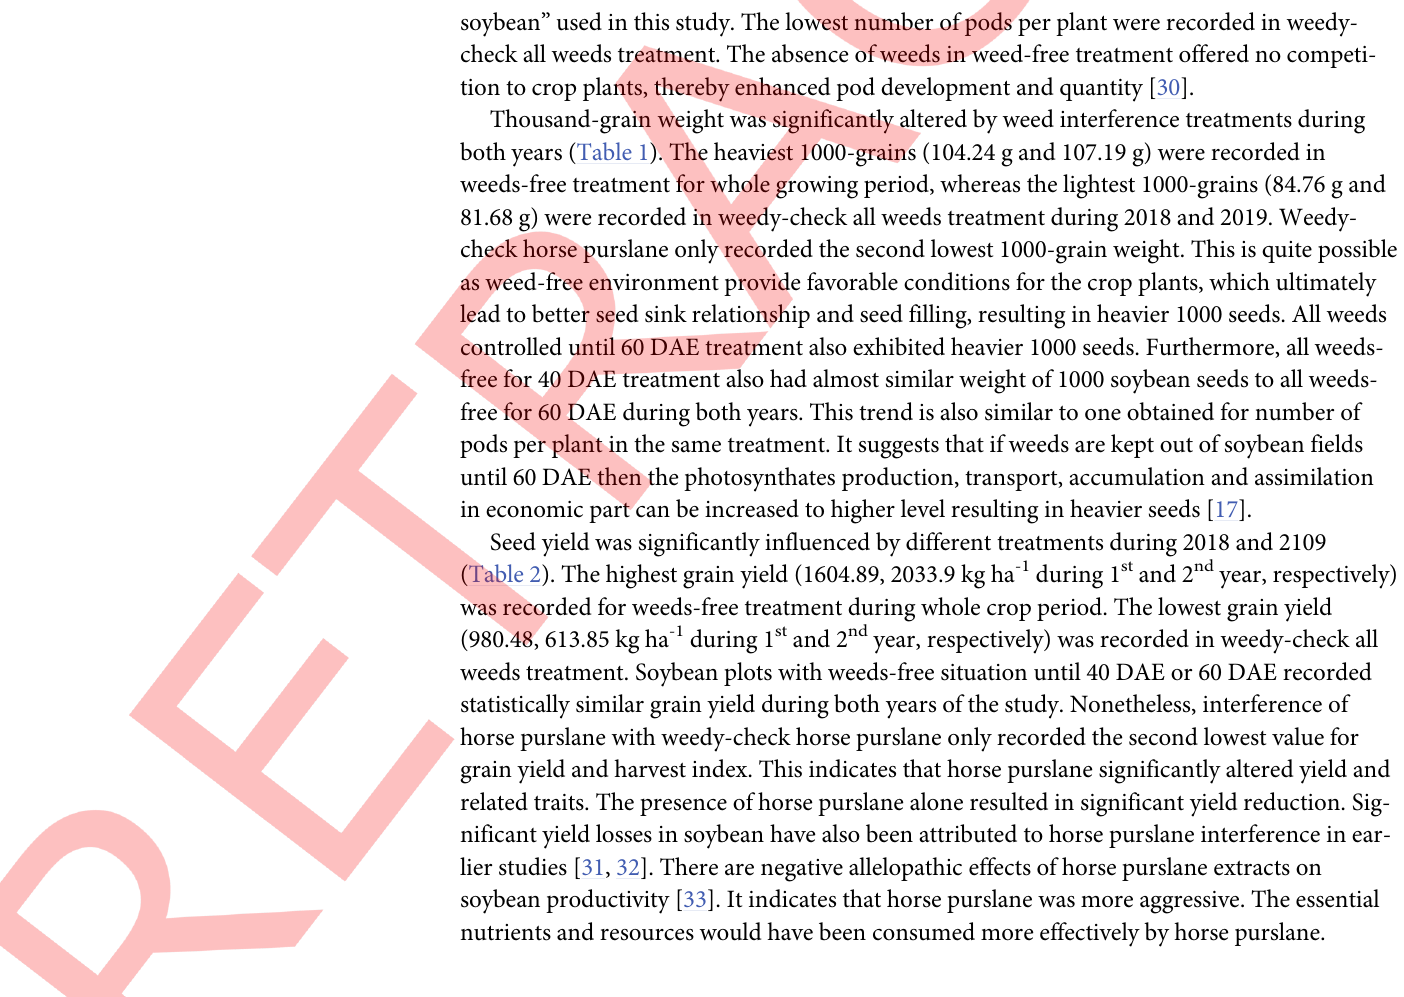
nutrients and resources would have been consumed more effectively by horse purslane.